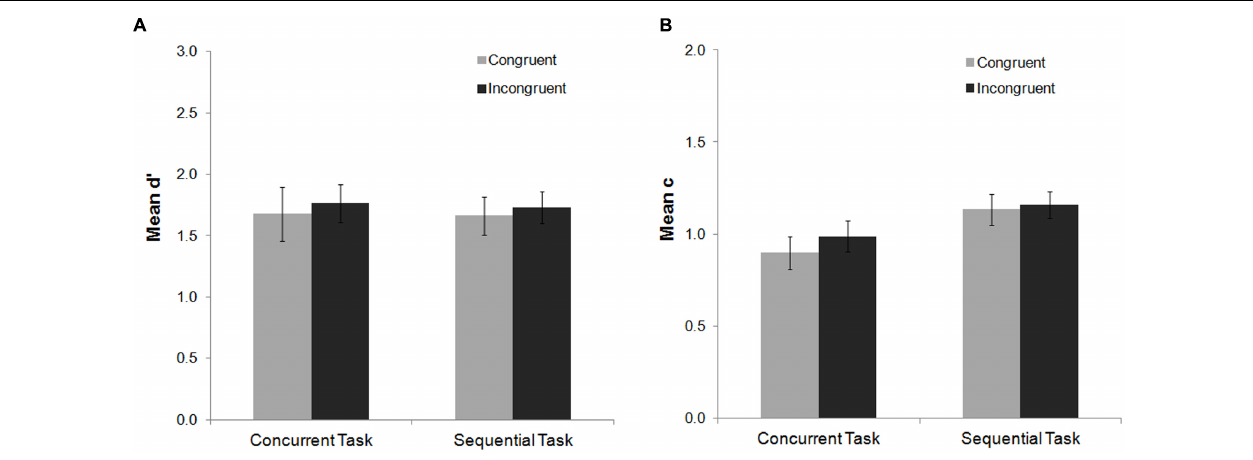
FIGURE 4 | Mean d (cid:48) and c indexes as a function of task and Stroop congruency in Experiment 2. No main effects or interactions were found for the mean d (cid:48) index (A) . For the mean c index (B) no congruency effects were found. A main effect of task was observed, but it did not interact with the congruency factor. Bars represent standard